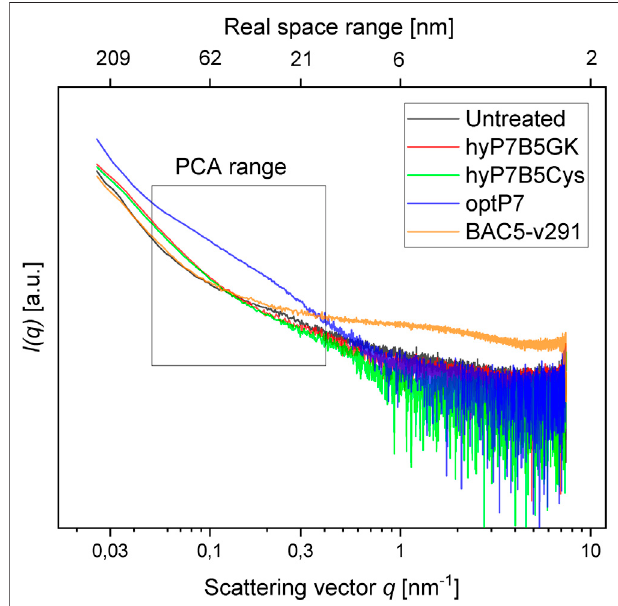
FIGURE 3 | Scattering data from untreated E. coli , and treated with four different peptides after 60 min, as measured at the P12 BioSAXS beamline at PETRA III (Hamburg, Germany). The principal component analysis (PCA) was calculated using data within the box.